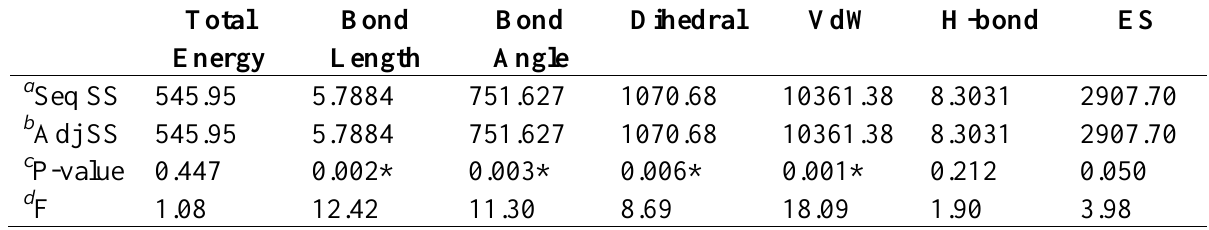
Table 10. Analysis of Variance for all molecular